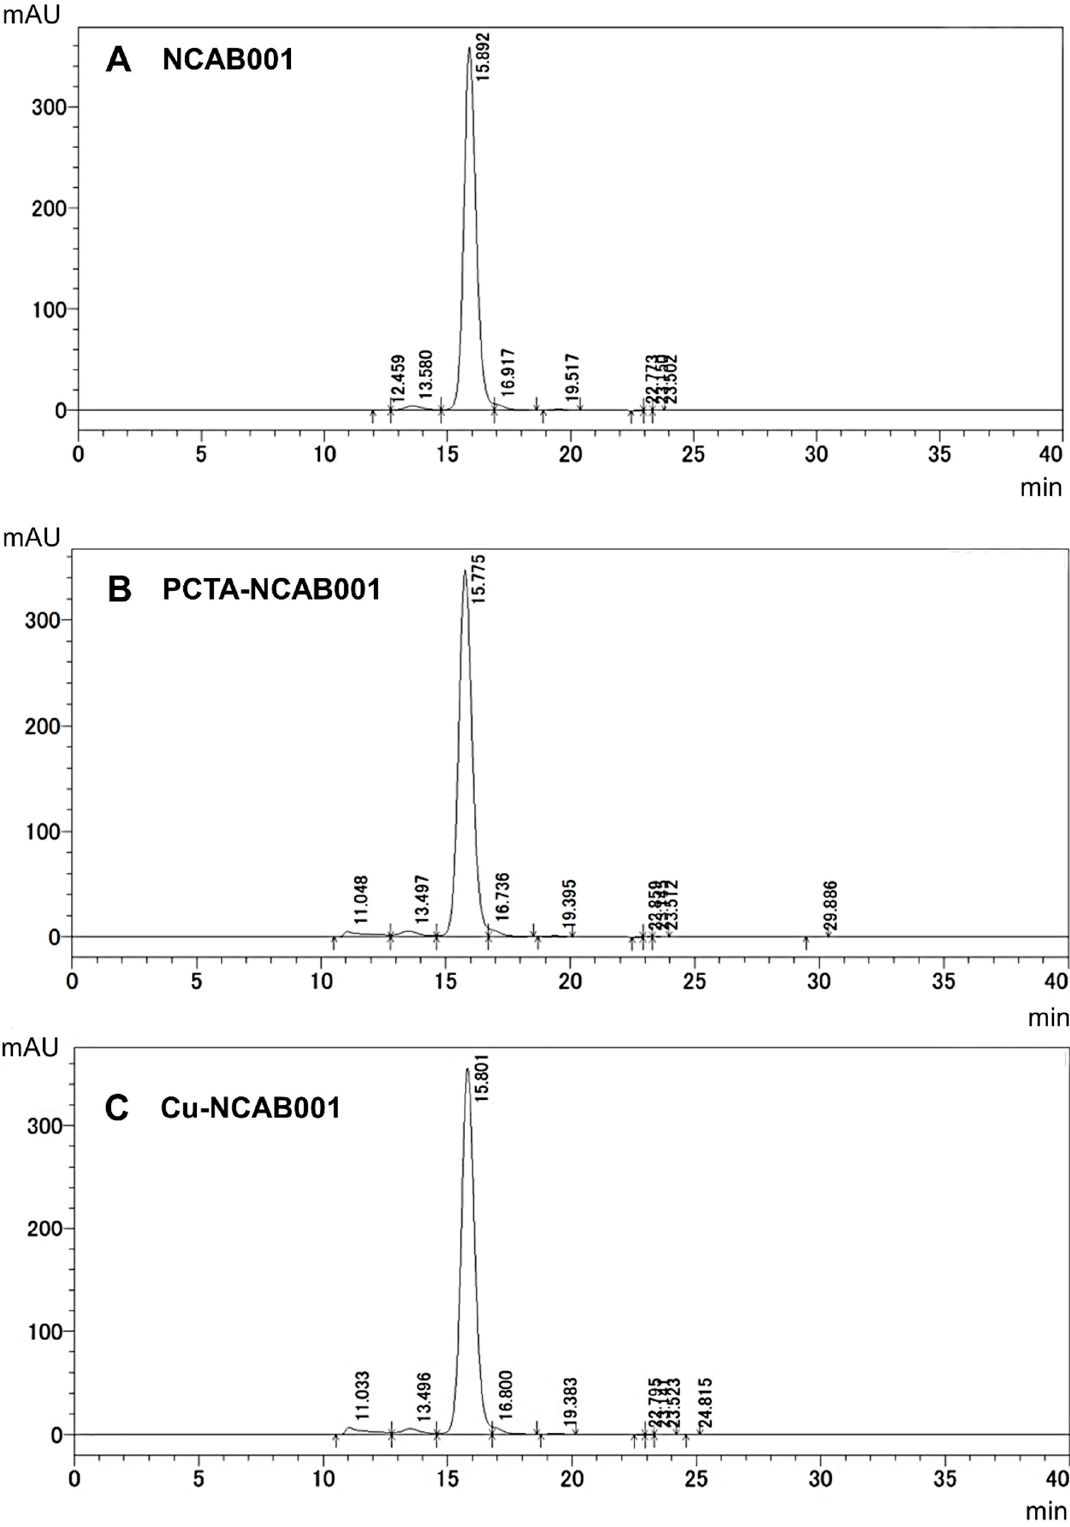
Figure 2. Size variants of NCAB001 ( A ), PCTA-NCAB001 ( B ), and Cu-NCAB001 ( C ). A larger impurity was found in NCAB001 solution at the retention time of 13 min. An additional larger impurity was found in the PCTA-NCAB001 and Cu-NCAB001 solutions at a retention time of 11 min.